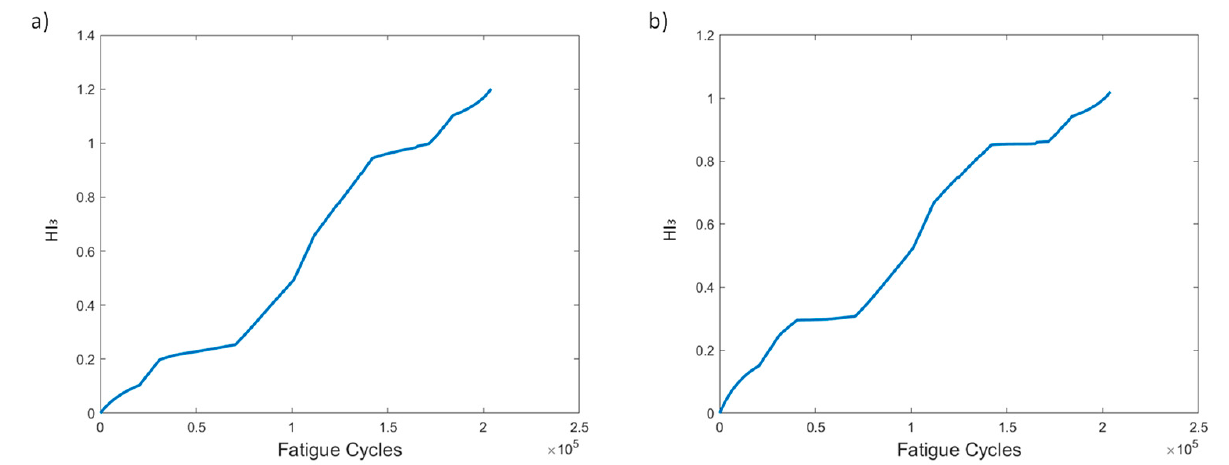
Figure 16. HI 3 progression through time for the two pre-processing methods for specimen VA-1: ( a ) method 1, ( b ) method 2.